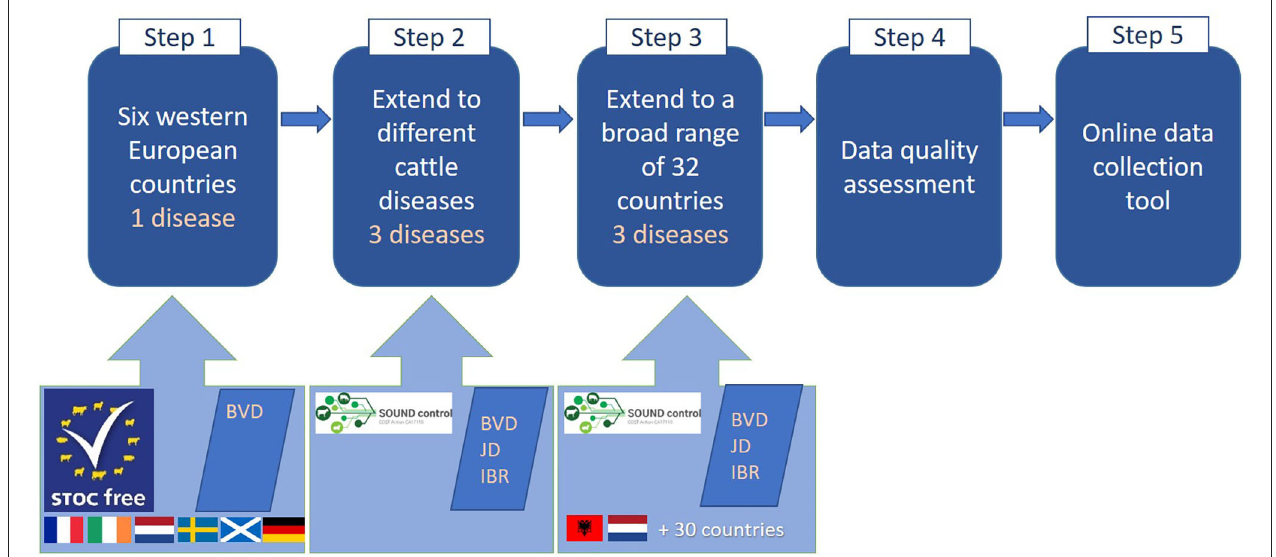
FIGURE 1 | Stepwise process that was followed to come to the final online data collection tool.